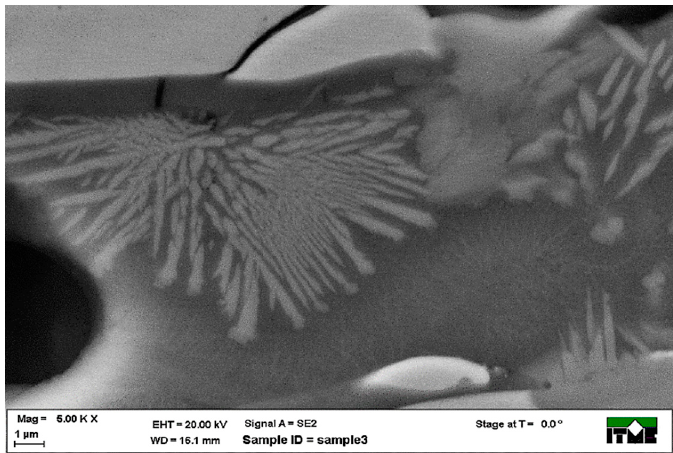
Figure 7. Crystal precipitation in the inter-phase boundary of crystals on a Fe and Al matrix.